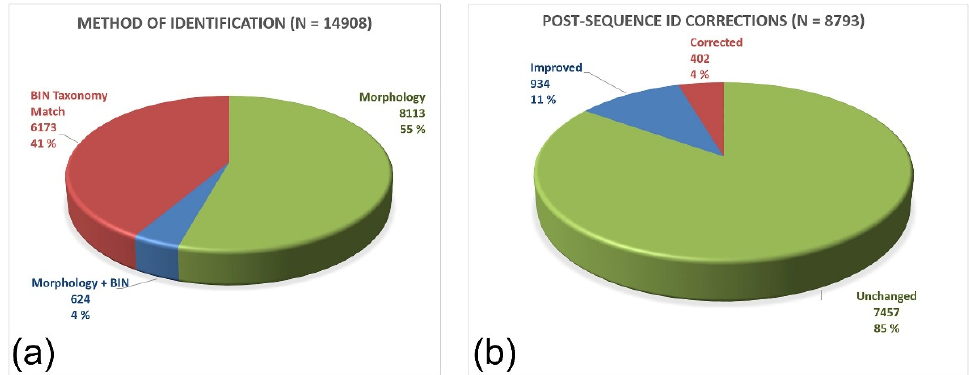
Figure 4. Method of identification ( a ) and post-sequence corrections ( b ) carried out on the Nordic dataset of Sciaroidea as of 15 September 2021. The entire Nordic dataset ( n = 14,908) contains a large proportion of public data apparently identified only by BIN taxonomy matching. In our private data set ( n = 8793), every submitted specimen was identified as much as possible pre-sequence and nearly every post sequence change in identification was noted on BOLD. Those sums to 402 (4.6%) corrections and 934 (10.6%) improved identifications while 7457 (84.8%) remains unchanged.